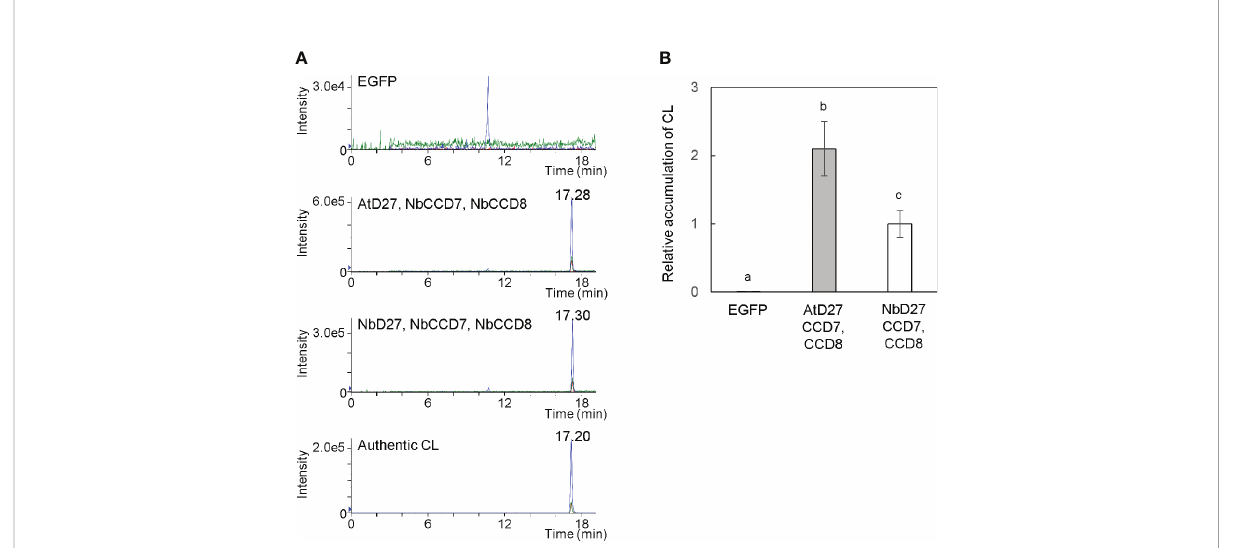
FIGURE 2 Detection of carlactone (CL) in Nicotiana benthamiana leaves. (A) N. benthamiana leaves were in fi ltrated with an Agrobacterium mixture containing pBYR2HS-EGFP; pBYR2HS-AtD27, -NbCCD7, and -NbCCD8; or pBYR2HS-NbD27, -NbCCD7, and -NbCCD8. Seven days after in fi ltration, the leaves were immersed into acetone, and the contents of CL were measured by LC-MS/MS. Multiple reaction monitoring chromatograms of CL (blue, 303.00/97.00; red, 303.00/189.00; green, 303.00/207.00; m/z in positive mode) are shown. (B) The relative accumulation of CL was calculated. The mean of CL accumulation in leaves in fi ltrated with pBYR2HS-NbD27, -NbCCD7, and -NbCCD8 was set to 1. The means ± SE (n = 3) from a representative of two biological replicates are indicated. The letters on the top of the error bars indicate the statistically signi fi cant differences according to Tukey-Kramer ’ s test (P <